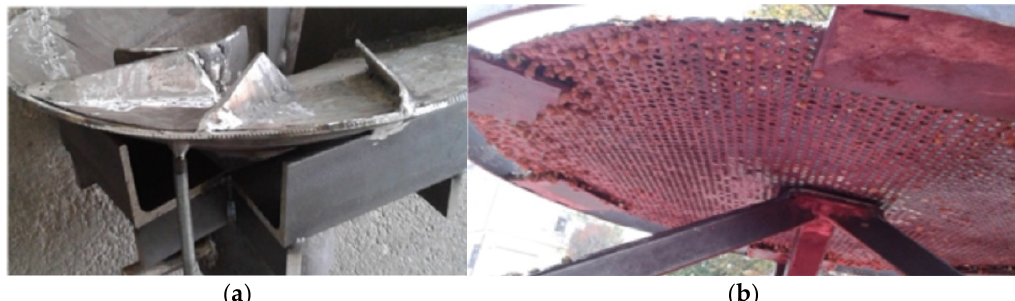
Figure 4. Second prototype realisation: ( a ) working chamber with multiple tangential straight wings; ( b ) extrusion of pitted olive pulp.